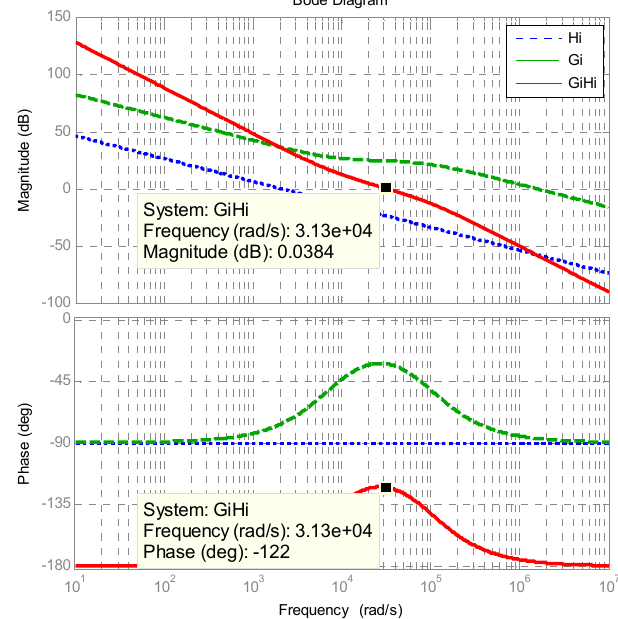
Figure 4. Bode plot of shunt active power filter (APF) inductor current control loop.